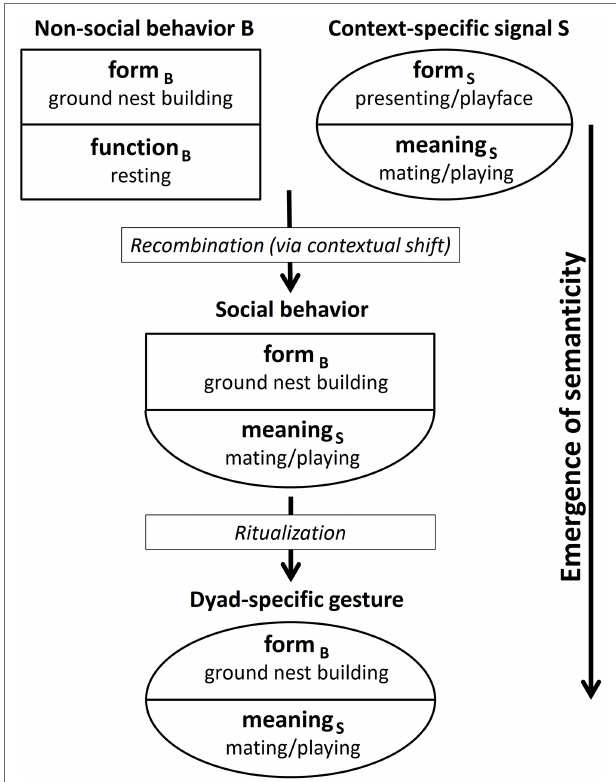
FIGURE 1 | Emergence of a dyad-specific gesture from a non-social